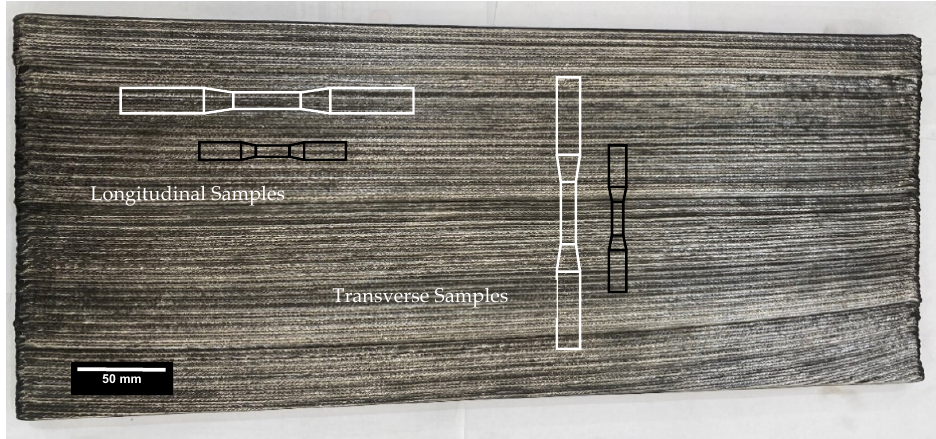
Figure 2. A test wall produced by WAAM using an ER2594 super duplex wire, 450 mm × 230 mm × 23 mm thick. White specimens indicated the fatigue specimens, and tensile specimens are shown in black.